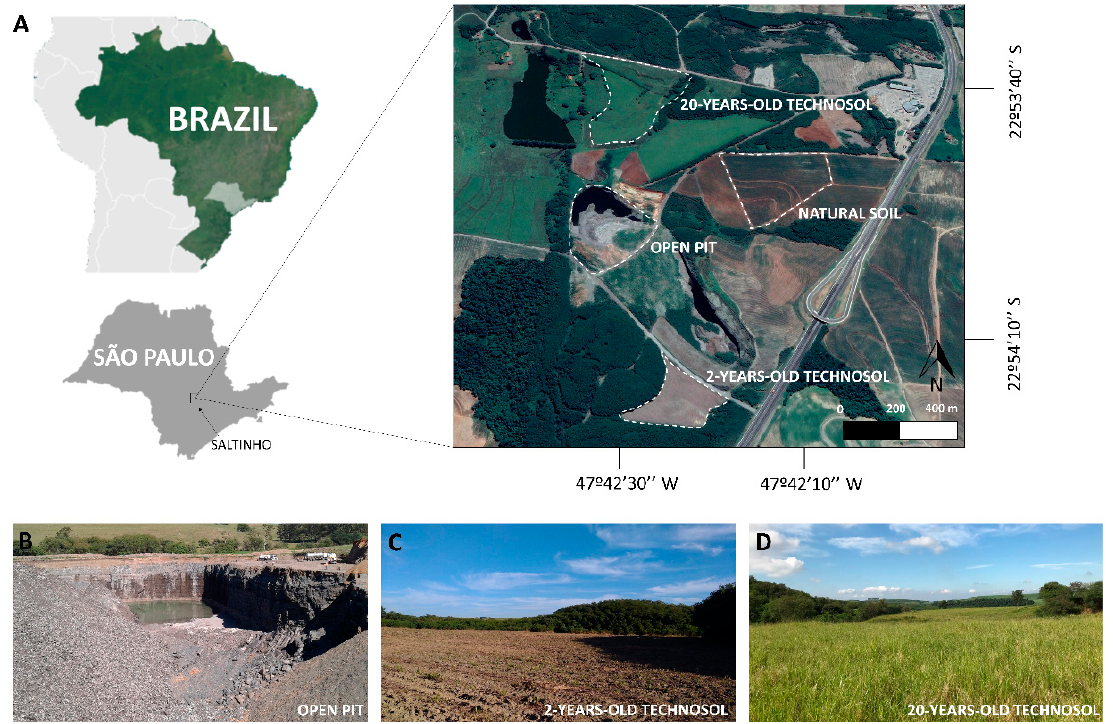
Figure 1. ( A ) Location of the study area in Saltinho, São Paulo State, Brazil, and distribution of the studied soils (image obtained on 21 May, 2018; Google TM Earth); ( B ) an open pit which is under rehabilitation; ( C ) Two-year-old Technosol grown with sugarcane; and ( D ) 20-year-old Technosol under pasture.